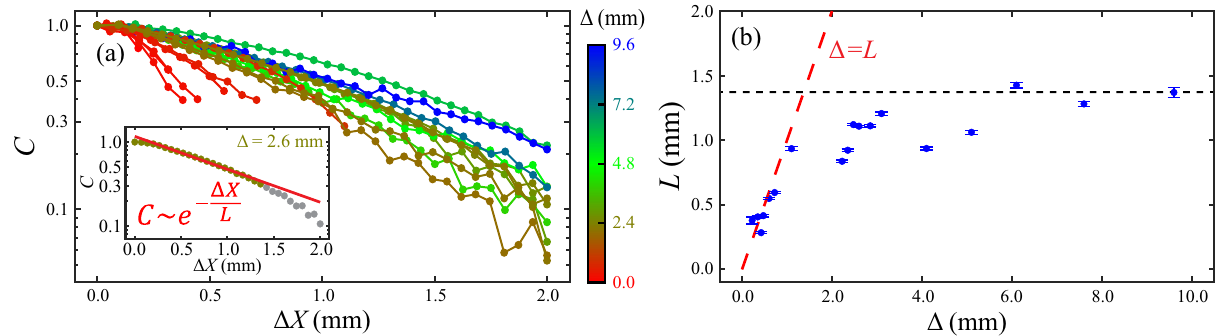
Figure 7. Simulations revealed that flows inside and outside of water-in-oil droplets ( r were correlated with a correlation length that increased with the oil layer thickness. ( a ) Normalized same-time velocity–velocity spatial cross-correlation functions between active fluid near the water–oil interface (within 100 µm) and oil for various oil layer thicknesses ( (cid:31) ). The correlation functions decayed with increasing distance between the active fluid element and the oil element ( (cid:31) X ). Inset: The initial decay length (defined as the correlation length) L of the correlation function was extracted by excluding the correlation data below 0.3 (gray dots) and fitting the remaining correlation data (olive dots) to an exponential function: e − � X / L with L as a fitting parameter (red line). ( b ) The correlation length increased linearly with the oil layer thickness (dashed red line) before reaching its maximum (black dashed line). Error bars represent uncertainties in fitting the correlation function to an exponential function (inset in panel a